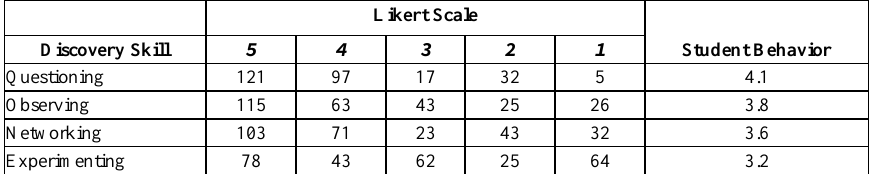
Table 2. Pre-survey of student behavior skills using “The Innovator's DNA” [44]. Likert